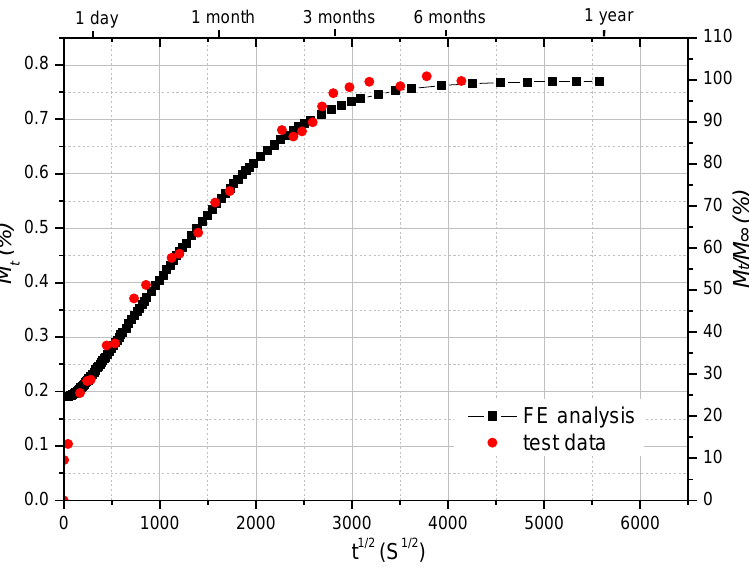
Figure 5. Comparison of moisture uptake curve between test results and FE analysis on FRP specimens for flexural test.